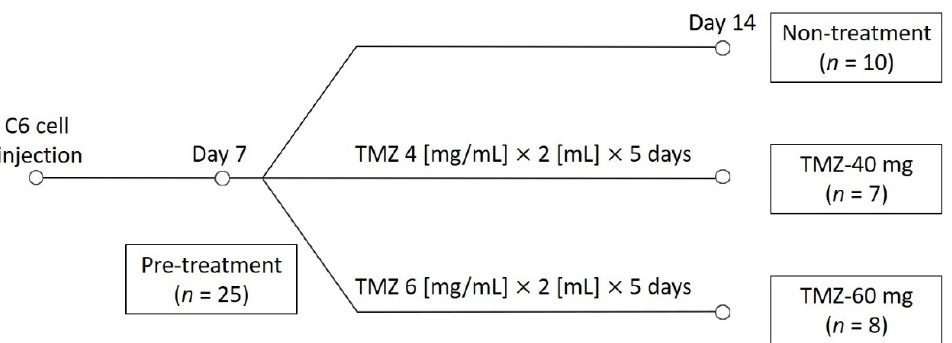
Figure 1. Schedule of the study. TMZ, temozolomide; TMZ-40 mg, the group that received a solution of TMZ dissolved in saline at a concentration of 4 mg/mL orally for 5 consecutive days starting on day 7; TMZ-60 mg, the group that received a solution of TMZ dissolved in saline at a concentration of 6 mg/mL orally for 5 consecutive days starting on day